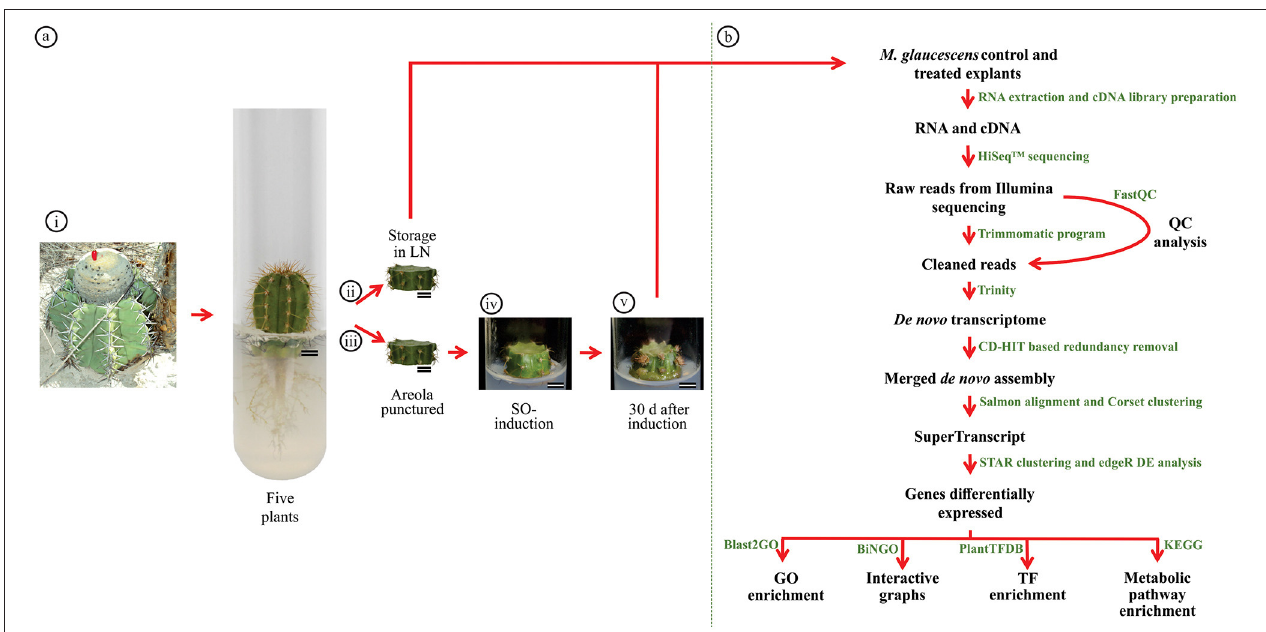
FIGURE 1 | Melocactus glaucescens tissues are used for transcriptome analysis and workflow of transcriptome assembly and characterization. (a) Collection of samples: (i) seeds were collected from a natural population of M. glaucescens (Morro do Chapéu, Bahia, Brazil); (ii) following germination, control explants